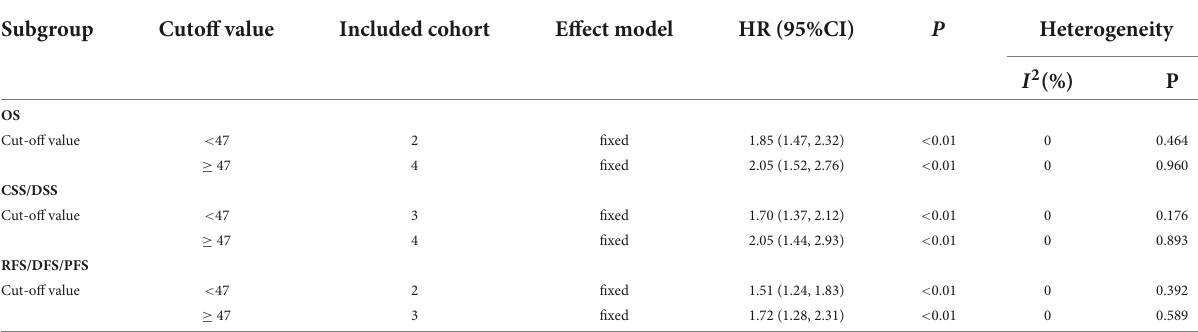
TABLE 3 Subgroup analysis of survival